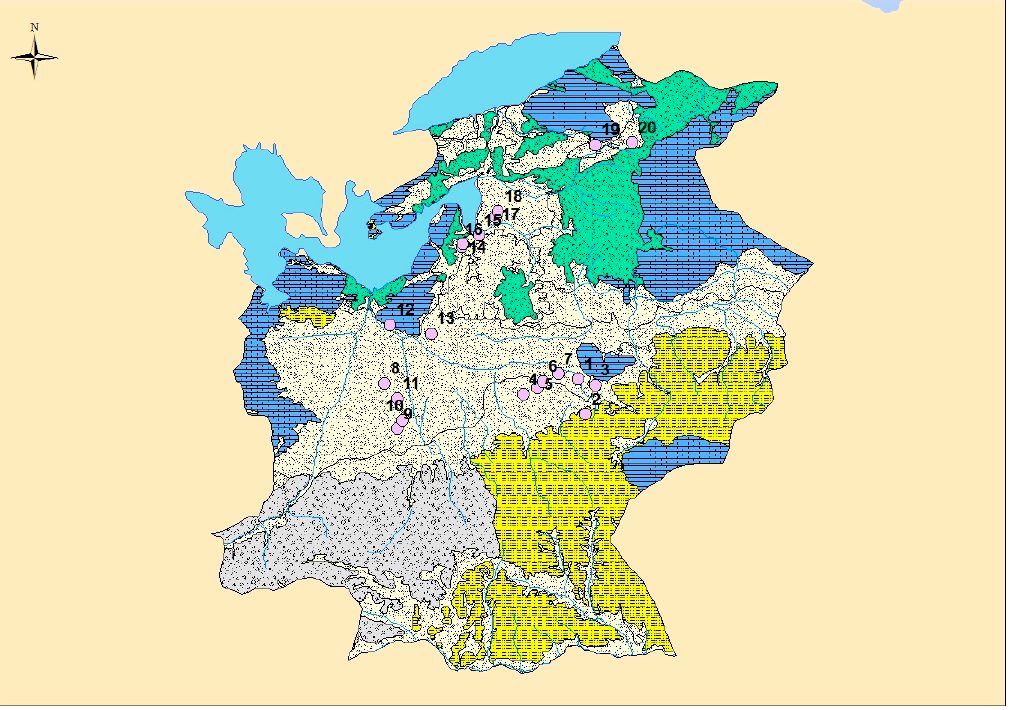
Figure 2. Sampling Figure 2. Sampling points.